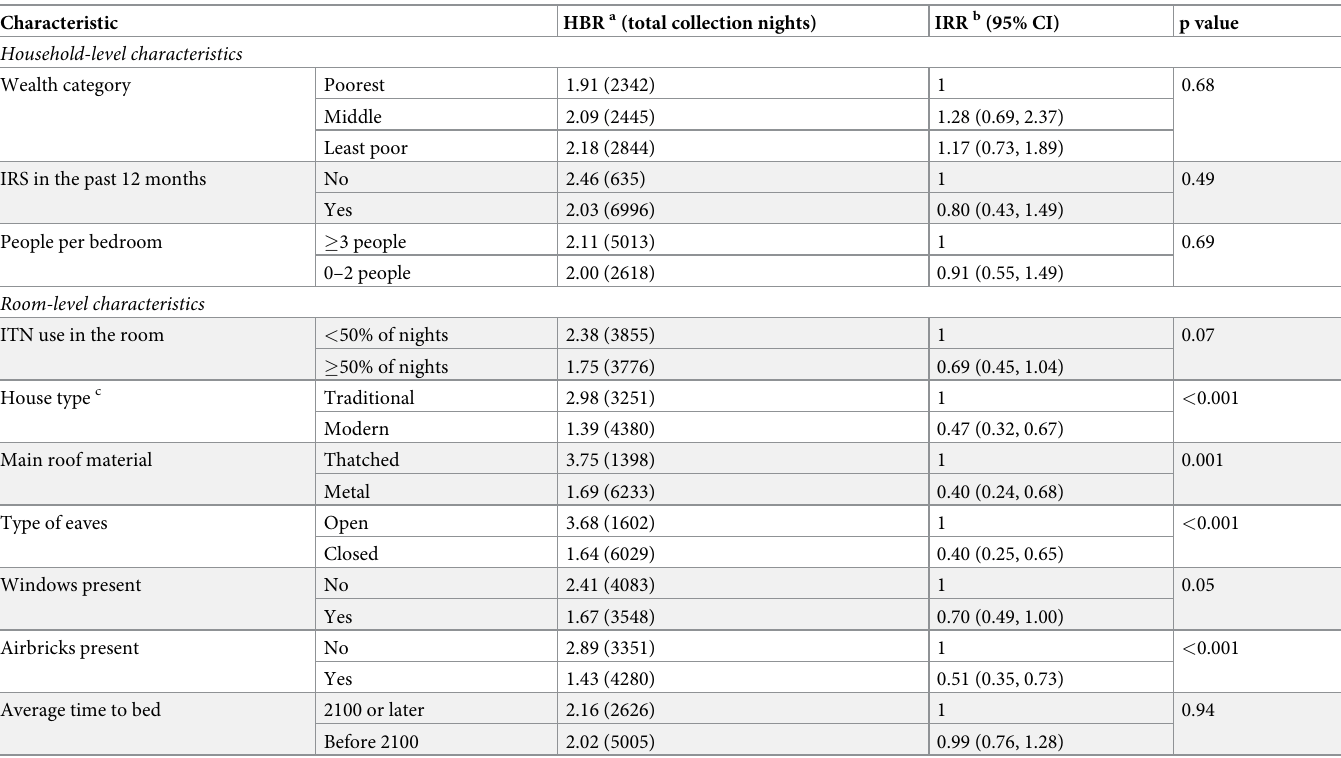
Table 2. Association between room characteristics and malaria vector density in Nagongera, Uganda (adjusted